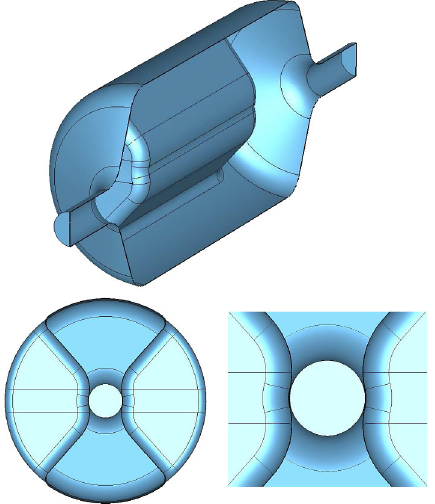
FIG. 29. Modified rf-dipole design with trapezoidal-shaped parallel bars indented in the beam line area.